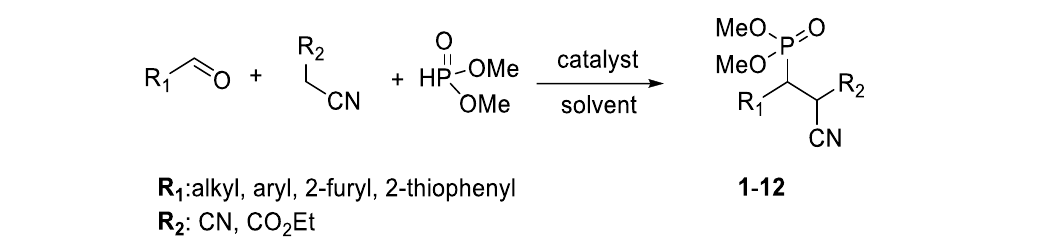
nitriles 11 and 12. Table 1. Model Knoevenagel – phospha – Michael addition to malononitrile catalyzed by enzymes. [a] Optimization studies.